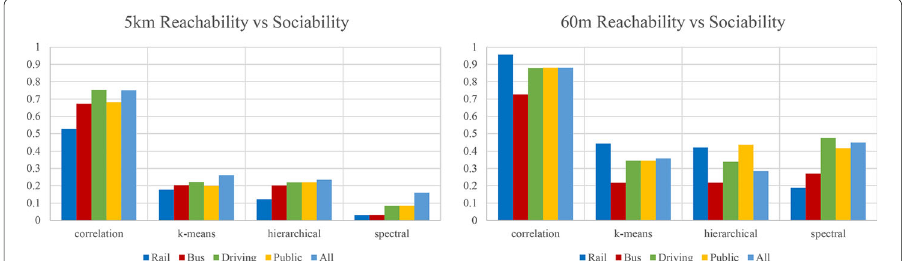
Fig. 11 The correlation and group member mutual information between reachability and sociability for selected subnetworks. Tabular data available in Additional file